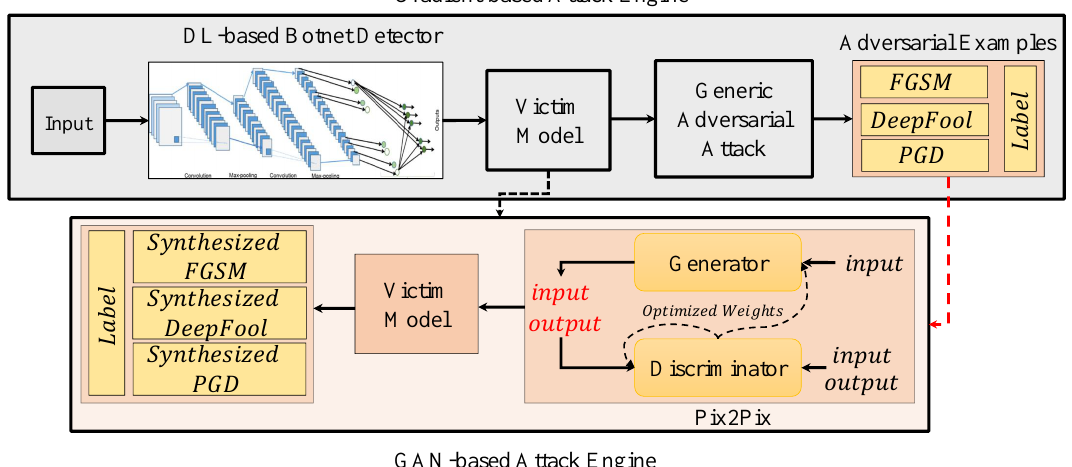
Figure 3. General structure of the GAN-based adversarial attacks on DL-based botnet detection system. Here, we employed Pix2Pix to synthesize new adversarial examples that are similar to adversarial examples generated in Section